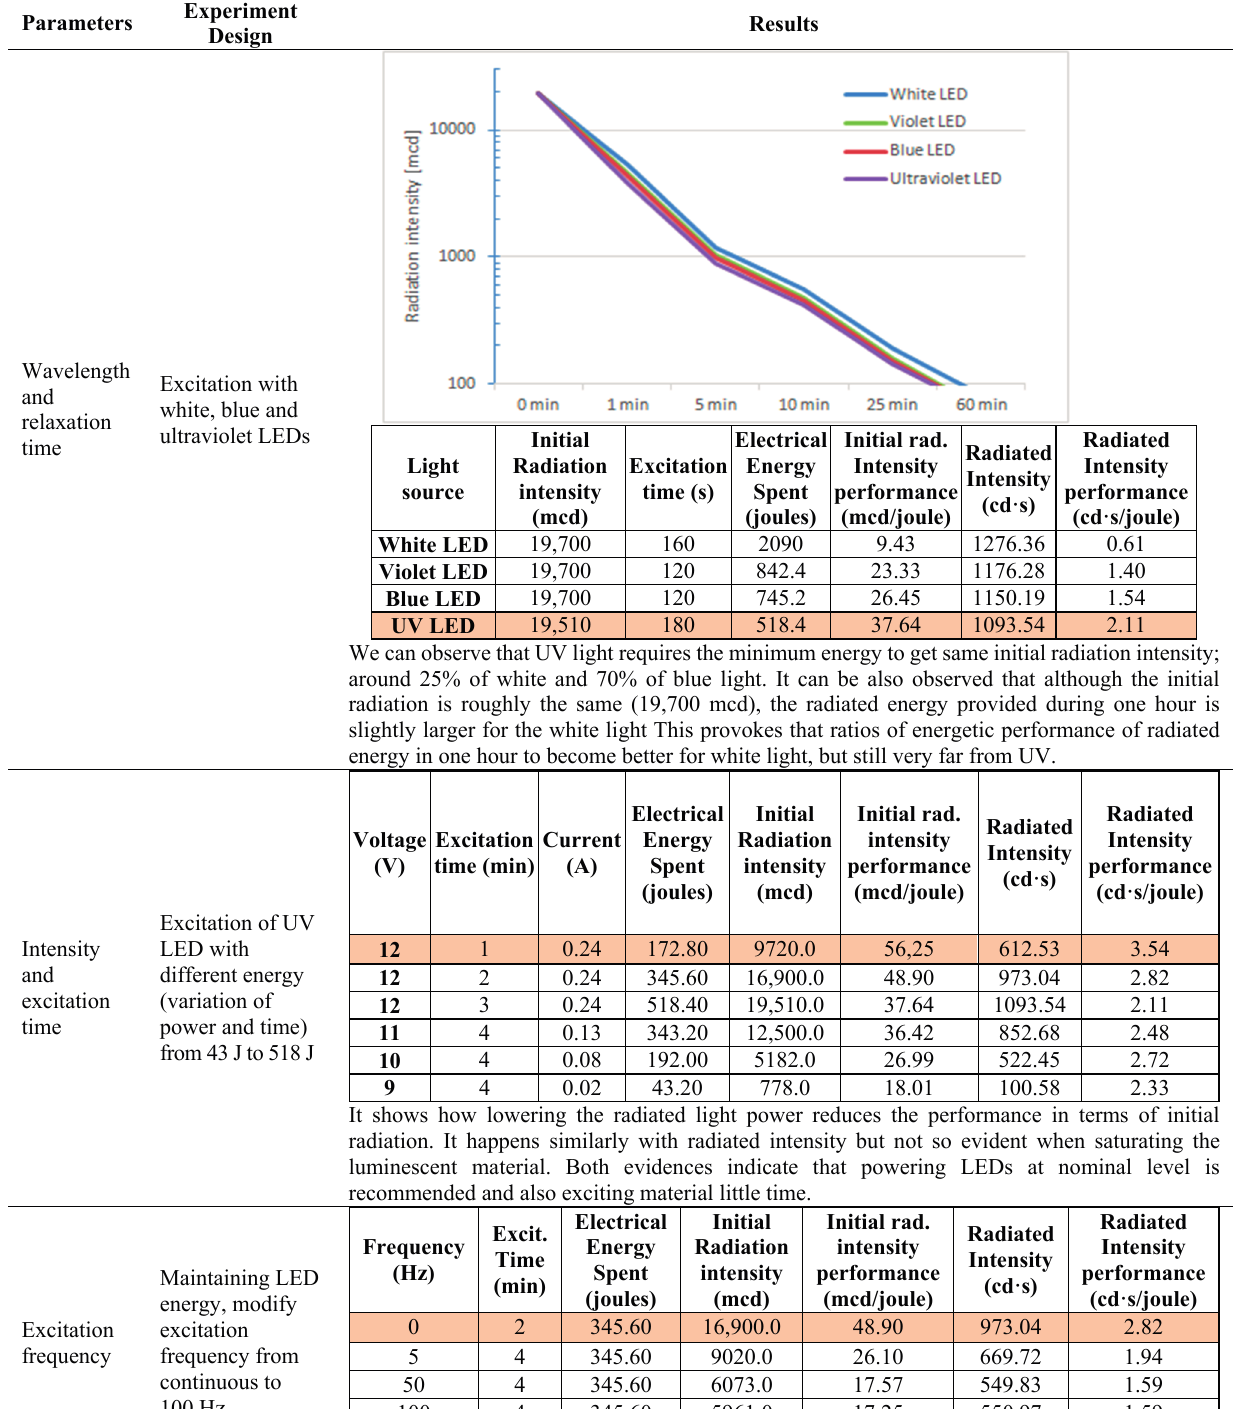
Table 1. Parameters affecting the efficiency of Smart Signal with phosphorescent support.